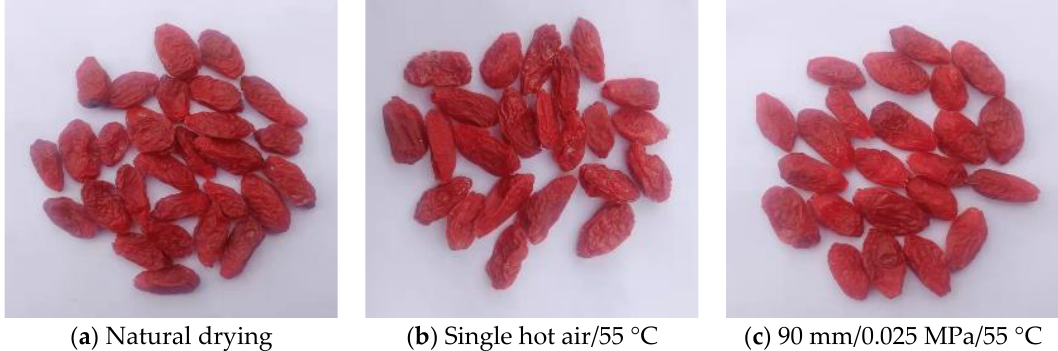
Figure 12. Macrostructure of L. barbarum under different drying conditions.